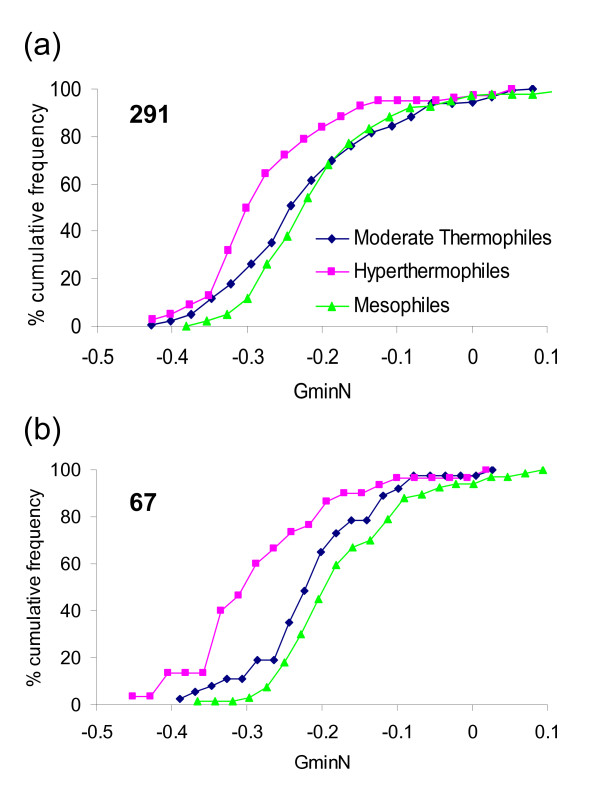
Separation by GminN. Cumulative frequency distributions of GminN calculated for each protein in the dataset and grouped according to origin as mesophile, moderate thermophile or hyperthermophile. (a) The 291 set. (b) The 67 subset of homologous pairs with E-value < 10-2 and a chain length difference of less than 30 residues.